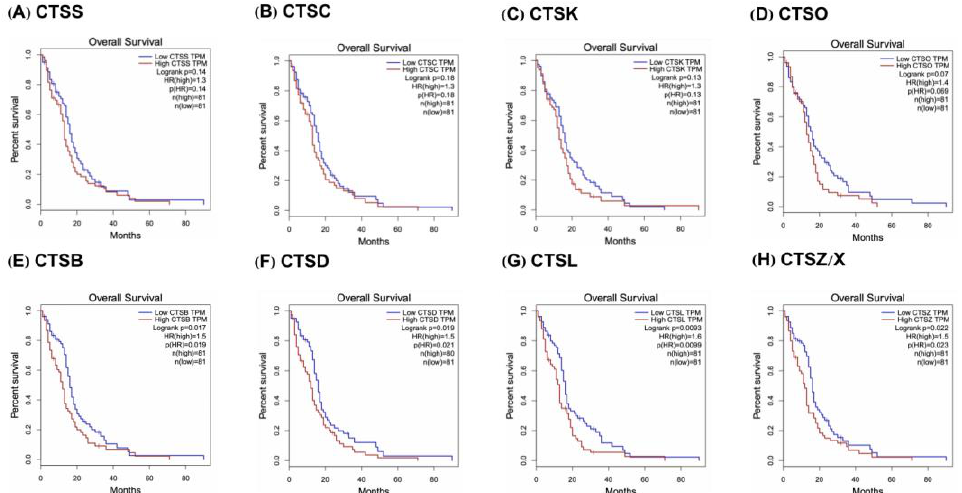
Figure 2. Cathepsin mRNA expression level in the OS of GBM patients. (A – D) The expressions of CTSS, CTSC, CTSK, and CTSO were not significantly associated with shortened overall survival in GBM patients ( p > 0.05). (E – H) The expressions of CTSB, CTSD, CTSL, and CTSZ/X were significantly associated with shorter overall survival in GBM patients ( p > 0.05). Number of tumor samples (n =